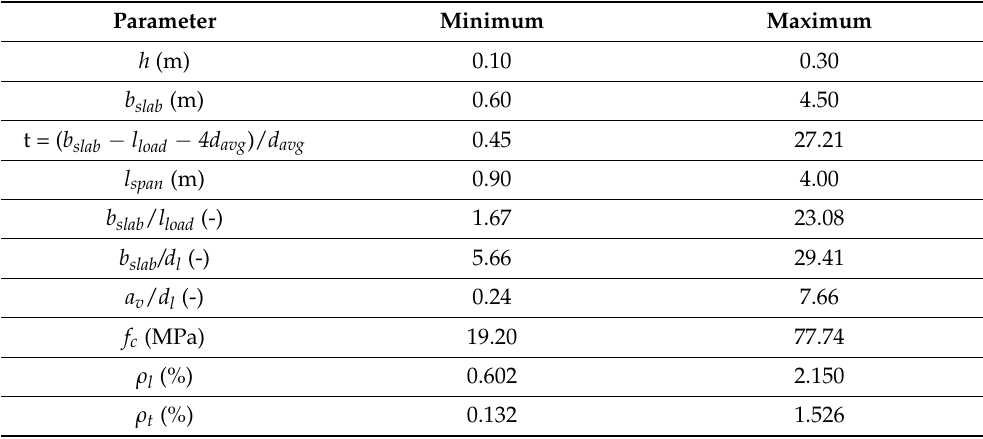
Table 5. Ranges of parameters in the